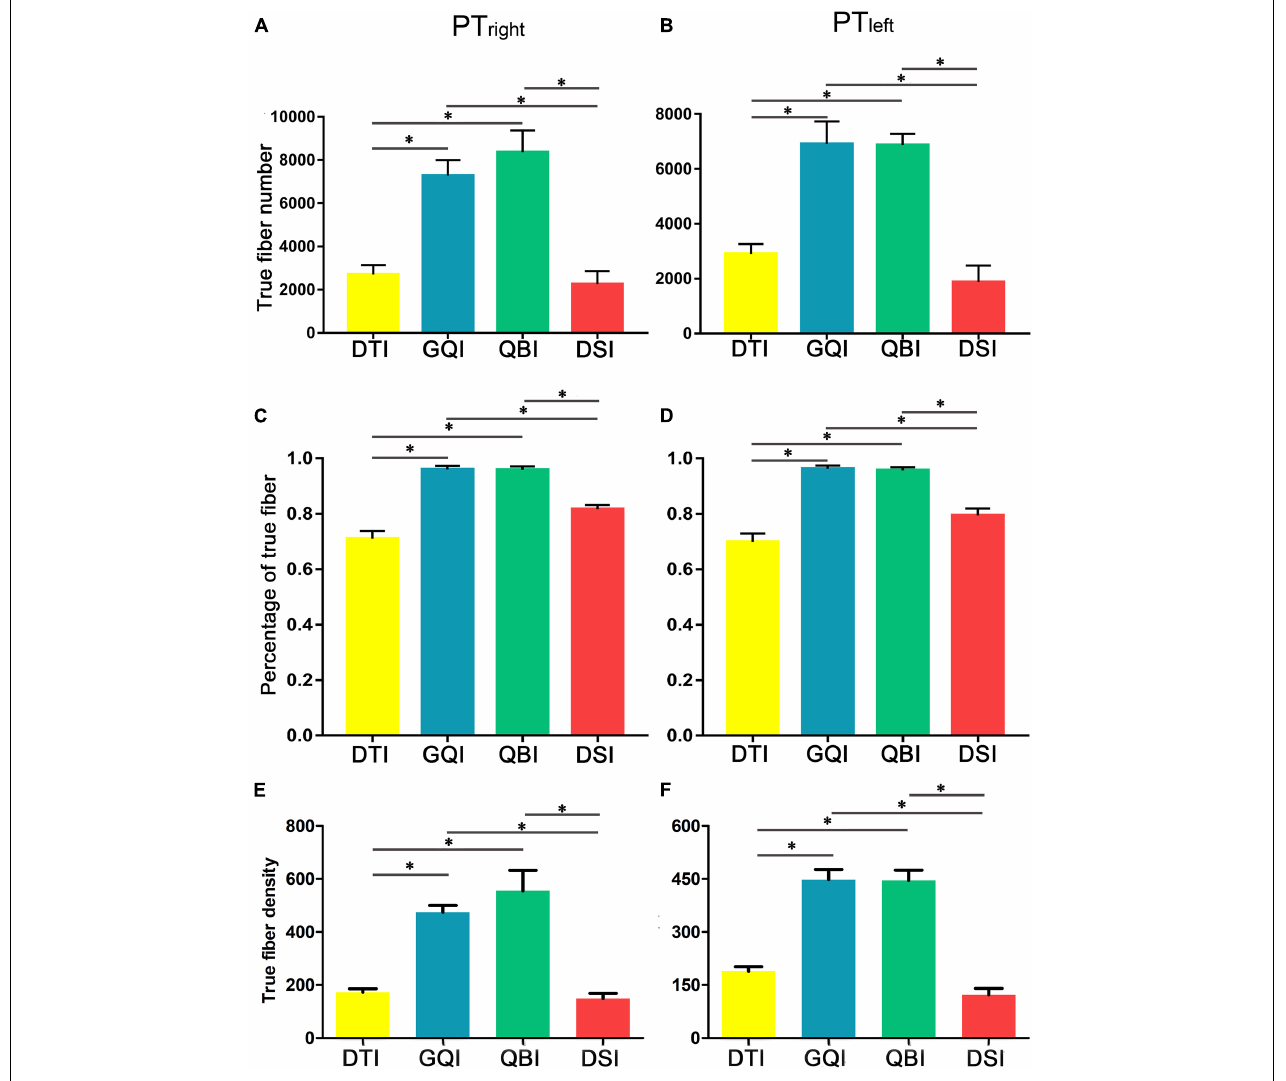
FIGURE 3 | Comparison of the true fiber number and density tracked based on four diffusion models. (A) The true fiber number of the right PT. (B) The true fiber number of the left PT. (C) The percentage of true fibers of the right PT. (D) The percentage of true fibers of the left PT. (E) The true fiber density of the right PT. (F) The true fiber density of the left PT. DTI, diffusion tensor imaging; DSI, diffusion spectral imaging; GQI, generalized Q-space sampling imaging; L, left; PT, pyramid tract; QBI, Q-ball imaging; R, right. * represents p < 0.0005 (0.05/96, Bonferroni corrected). The error bar represents standard errors.